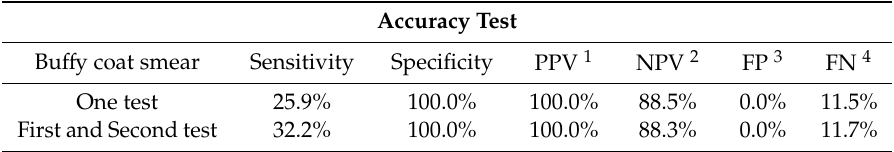
Table 2. Accuracy of staining smears of bu ff y coat compared with culture in the diagnosis of disseminated histoplasmosis in AIDS-patient in an endemic area of South America. Fortaleza, Cear á , Brazil,